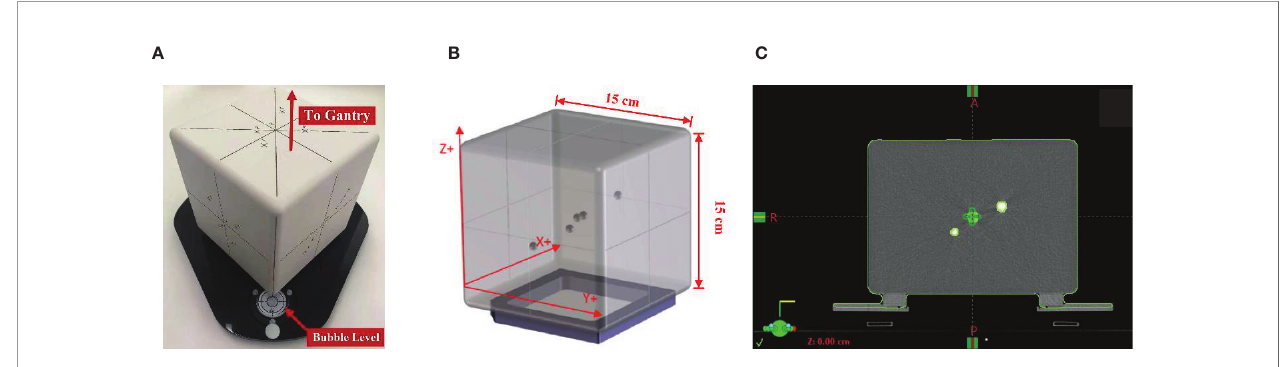
FIGURE 1 | AlignRT cube phantom used in this study: (A) the cube phantom was placed on a levelling plate with adjustable screws, and set up with one edge towards the LINAC gantry to facilitate AlignRT surface imaging; (B) fi ve radiopaque spheres with a diameter of 7.5 mm were asymmetrically embedded into the cube with one at the isocenter; (C) the plan isocenter was carefully placed on the central marker of the